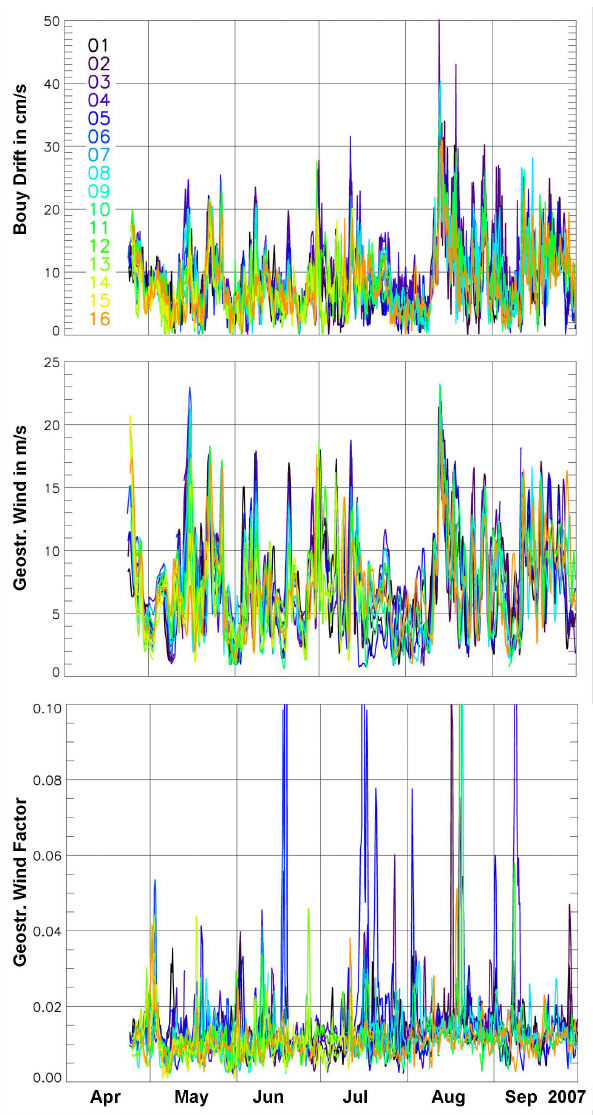
Fig. 7. Time series of 6-hourly ice drift (top), geostrophic wind (middle), and geostrophic wind factor (bottom) for all buoys of the D07